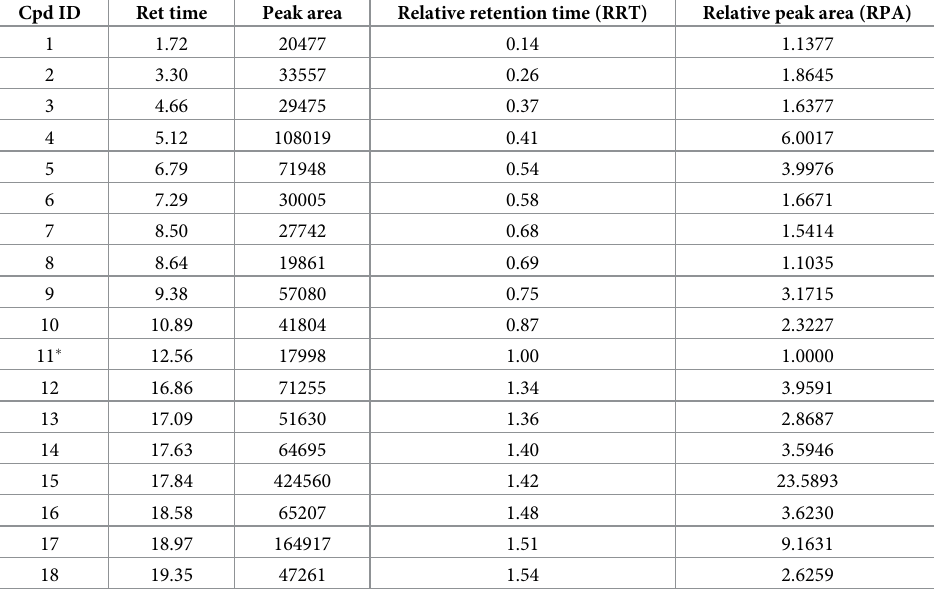
Table 4. Relative retention times (RRT) and relative peak areas (RPA) for E . senegalensis plant extracts as deter- mined for qualitative